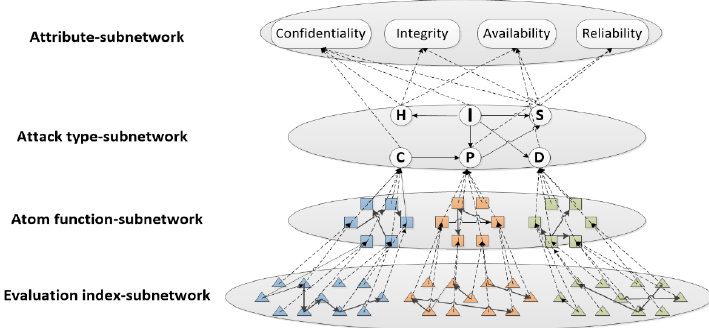
Fig. 1. The Structure Model of Directed Weighted Complex Network Index